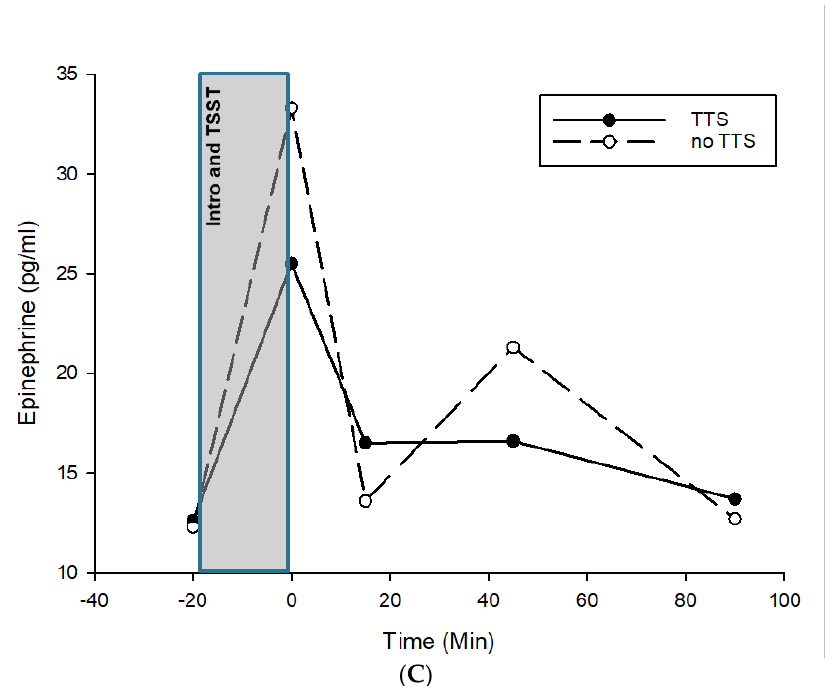
Figure 2. ( A ) Cortisol reactivity to TSST in TTS and non − TTS twin. Note: TSST = Trier Social Stress Test, TTS = twin with Takotsubo syndrome, no TTS = twin with no Takotsubo syndrome. ( B ) Norepinephrine reactivity to TSST in TTS and non-TTS twin. Note: TSST = Trier Social Stress Test, TTS = twin with Takotsubo syndrome, no TTS = twin with no Takotsubo syndrome. ( C ) Epinephrine reactivity to TSST in TTS and non-TTS twin. Note: TSST = Trier Social Stress Test, TTS = twin with Takotsubo syndrome, no TTS = twin with no Takotsubo syndrome.